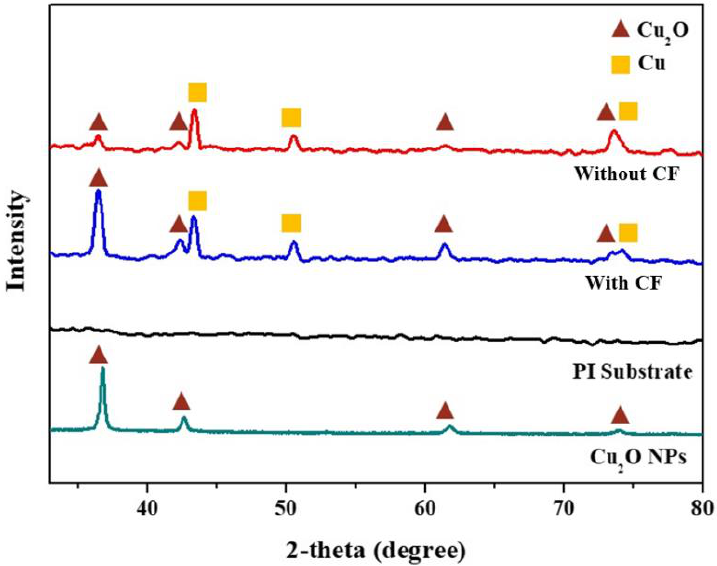
Figure 5. XRD patterns of laser-sintered structure, Cu2O nanoparticles, and PI substrate (CF: copper formate).